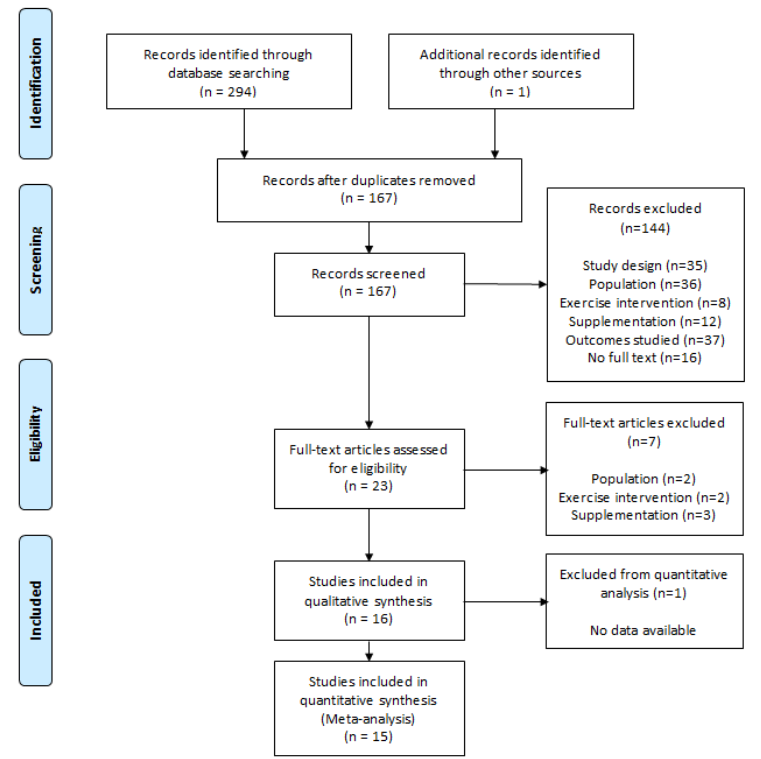
Figure 1. Search Preferred Reporting Items for Systematic Reviews and Meta-Analyses (PRISMA) flow diagram.